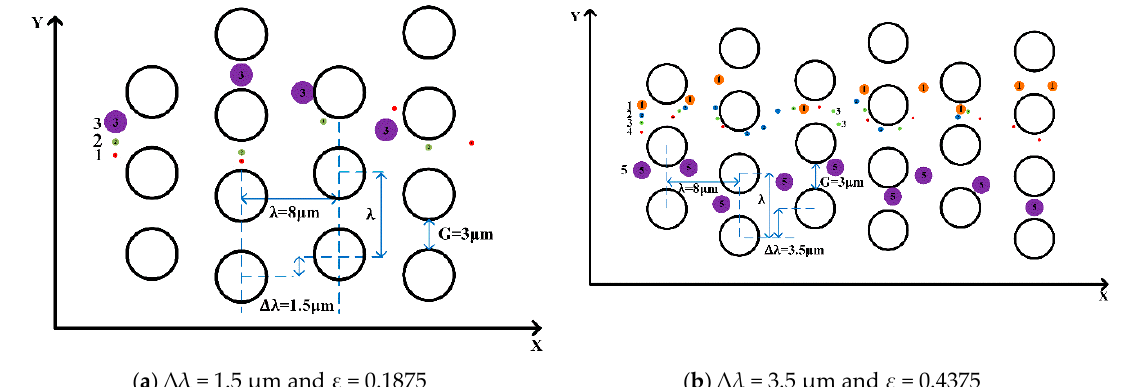
Figure 5. The trajectories of microspheres in a circular pillar are in “zigzag mode”. ( a ) The row shift is ∆ λ = 1.5 µm and ε = 0.1875. We indicate three microspheres in the channel (in purple, green, and red) of different sizes. ( b ) The row shift is ∆ λ = 3.5 µm and ε = 0.4375. Five fluid channels and five differently sized microspheres (shown in orange, green, blue, red, and purple, respectively) are labeled.